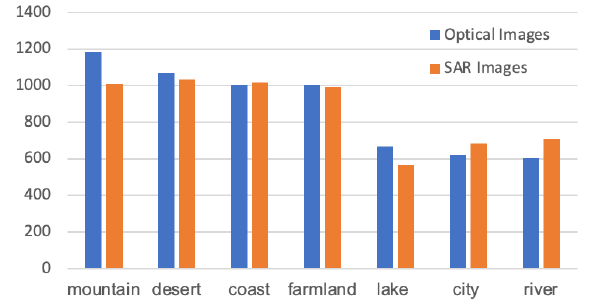
Figure 2 . Number of images per class